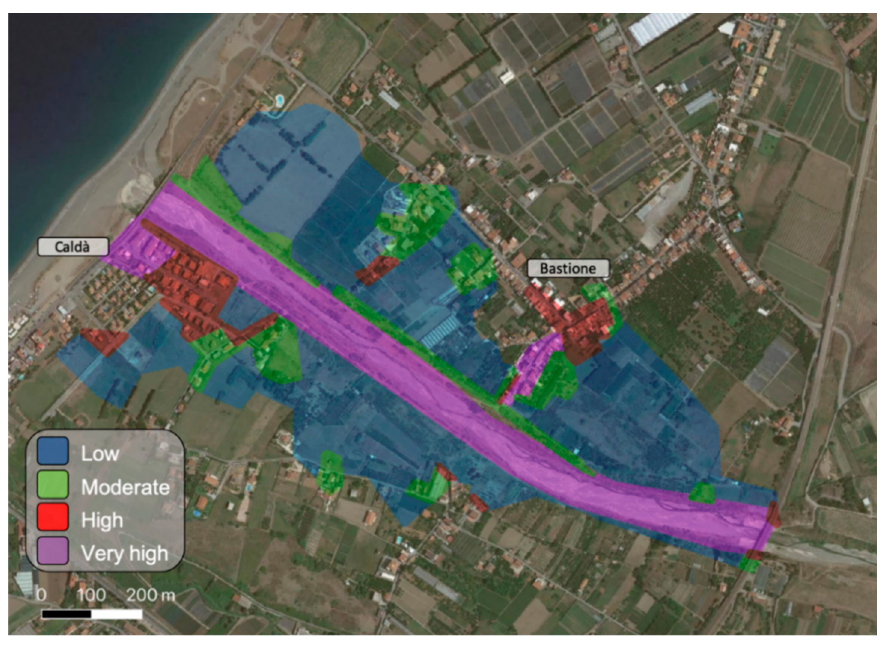
Figure 10. Flood risk map for the study area.